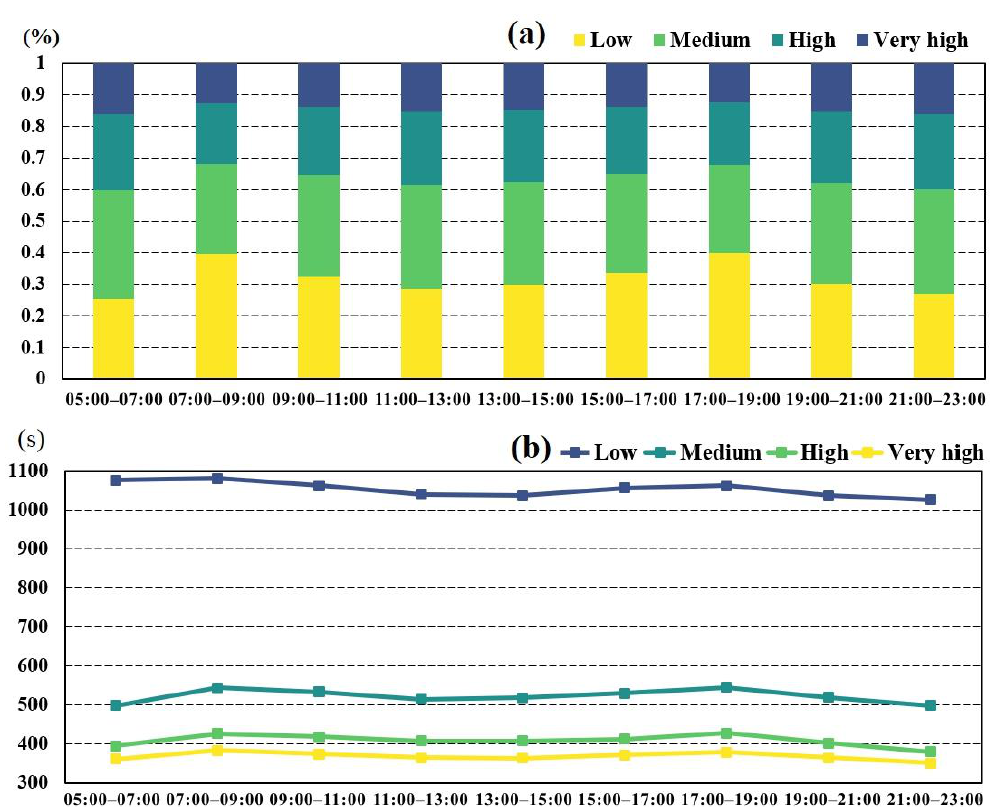
Figure 4. Change characteristics of fire incidents in 1 day. ( a ) Proportion of fire incidents and ( b ) average travel time of fire incidents at different accessibility levels.